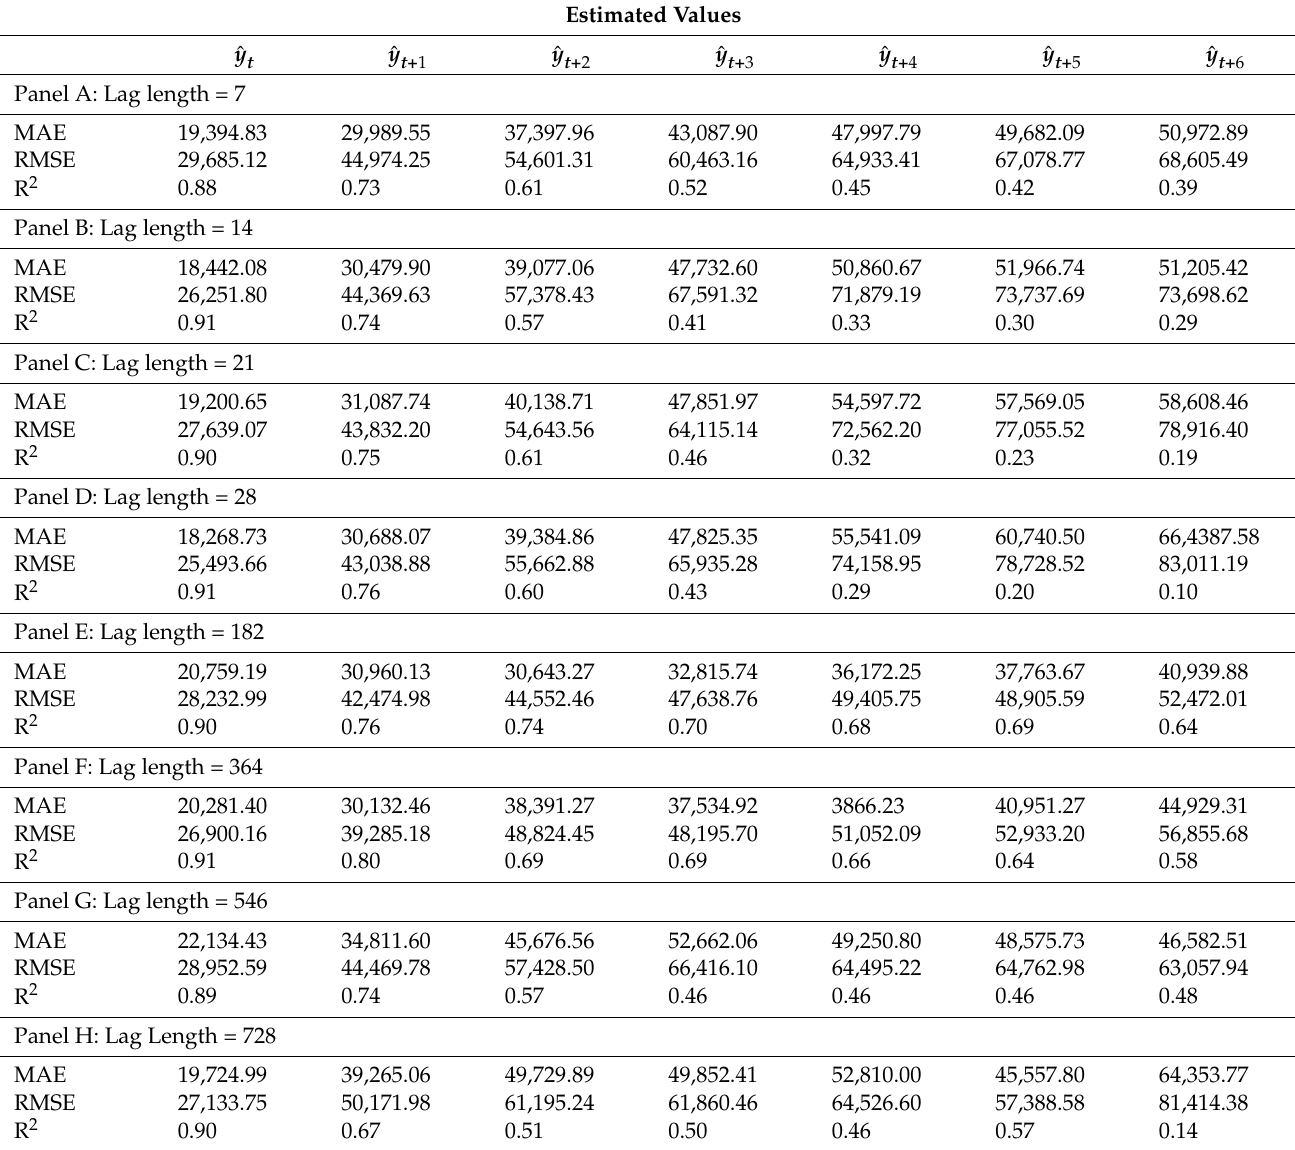
Table 4. Performance metrics of GRU on train set for different lag size. Estimated Values